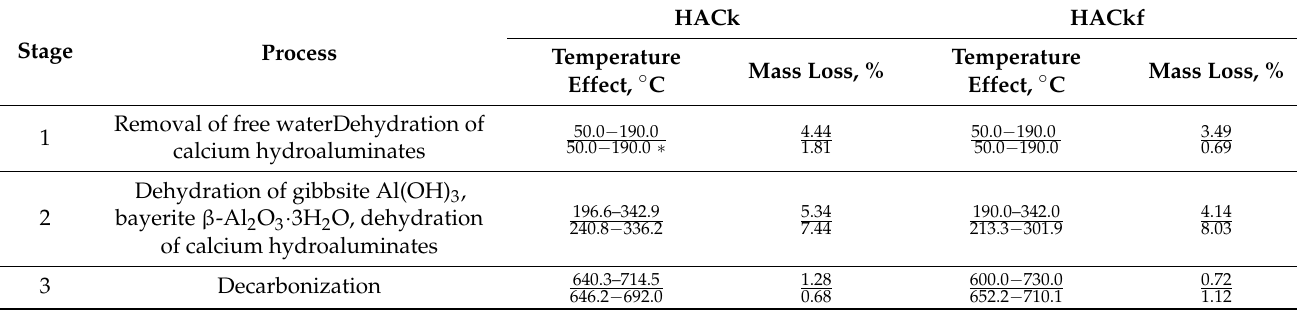
Table 4. Thermal effects and mass losses during heating of HACk and HACkf